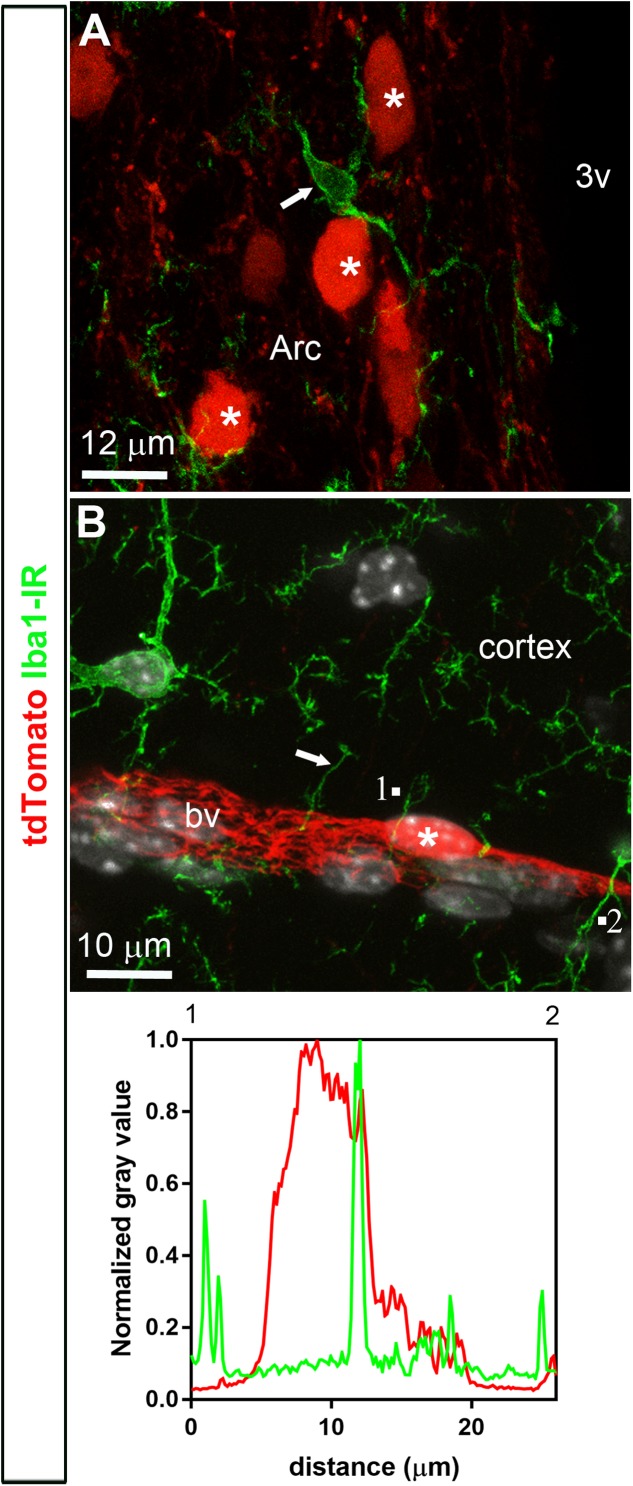
Distribution of Iba1 immunoreactivity relative to tdTomato-labeled cells. (A,B) Microglial cells throughout the brain were positive for Iba1 (arrows). In spite of the close proximity between microglial cells and tdTomato-labeled cells (asterisks), Iba1 never colocalized with tdTomato fluorescence and, furthermore, tdTomato-labeled cells never resembled microglial cells. The intensity plot profiles (between 1 and 2) demonstrated that Iba1 immunoreactivity did not coincide well with a tdTomato-positive perivascular cell. DAPI was converted to gray. Arc, arcuate nucleus; bv, blood vessel.